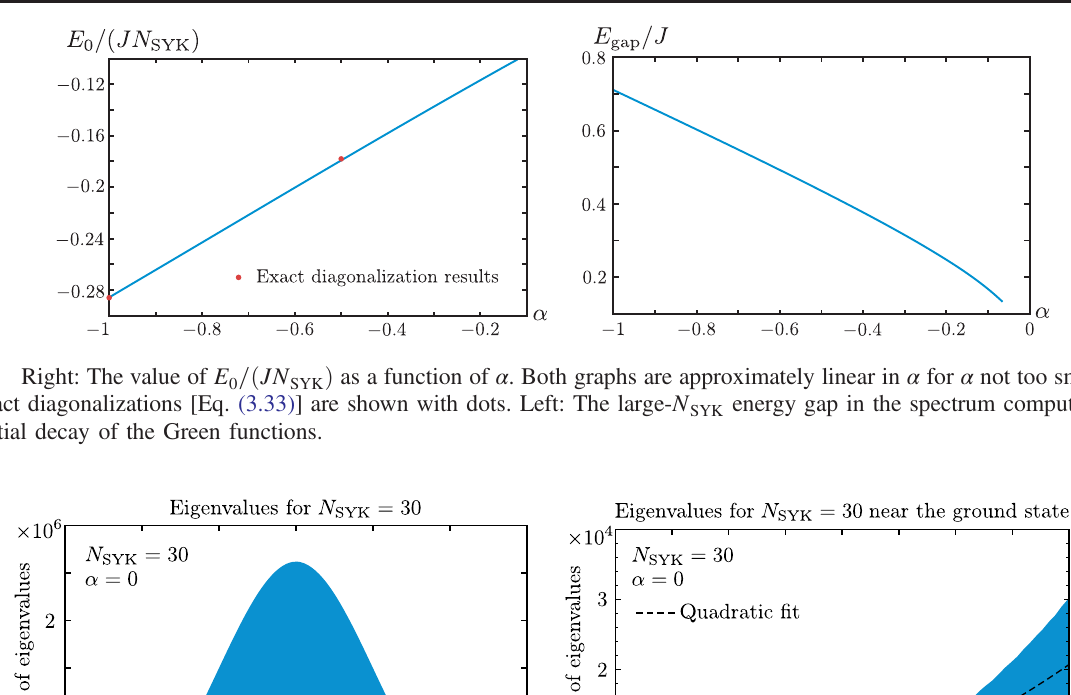
FIG. 17. Left: The energy spectrum for α ¼ 0 , i.e., for two decoupled SYK models, for a single sampling of N The same spectrum magnified near the lower ffiffiffiffiffiffiffiffiffiffiffiffiffiffiffiffi p 1 þ 3 α 2 J →